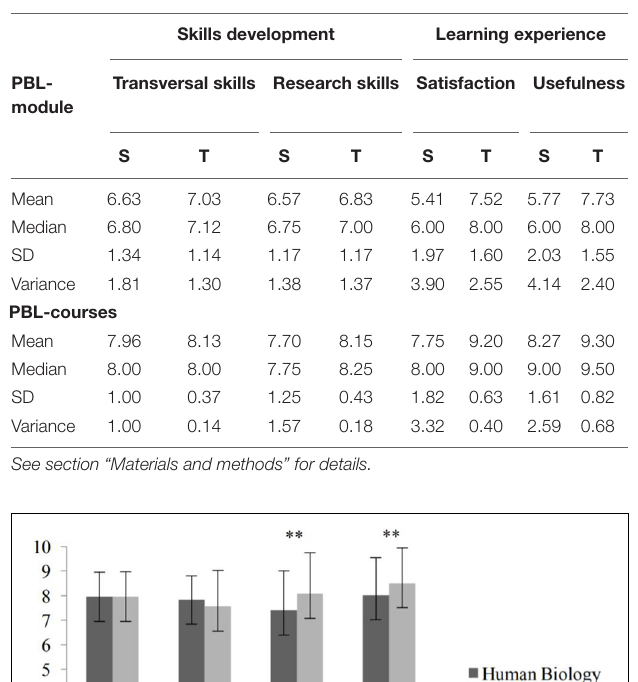
TABLE 3 | Statistical analysis of the scores given by students (S) and tutors (T) on their perceptions on the development of skills included in the transversal and research skills dimensions, as well as the learning experience dimension, in the PBL-module ( n = 330 students, n = 34 tutors) and the PBL-courses ( n = 277 students, n = 10 tutors).